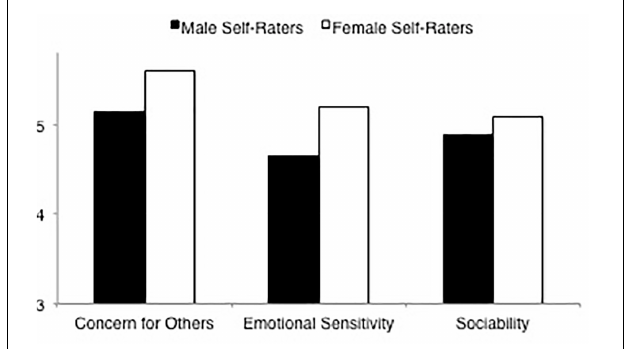
FIGURE 3 | Ratings of communality dimensions (concern for others, emotional sensitivity, sociability) by male and female